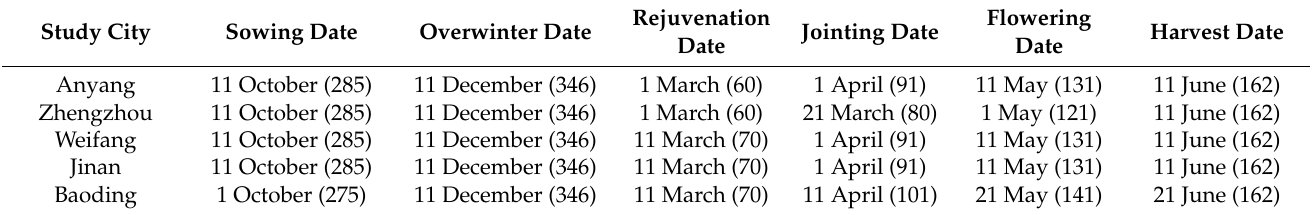
Table 2. The date and ordinal of winter wheat growing period planted in five cities.